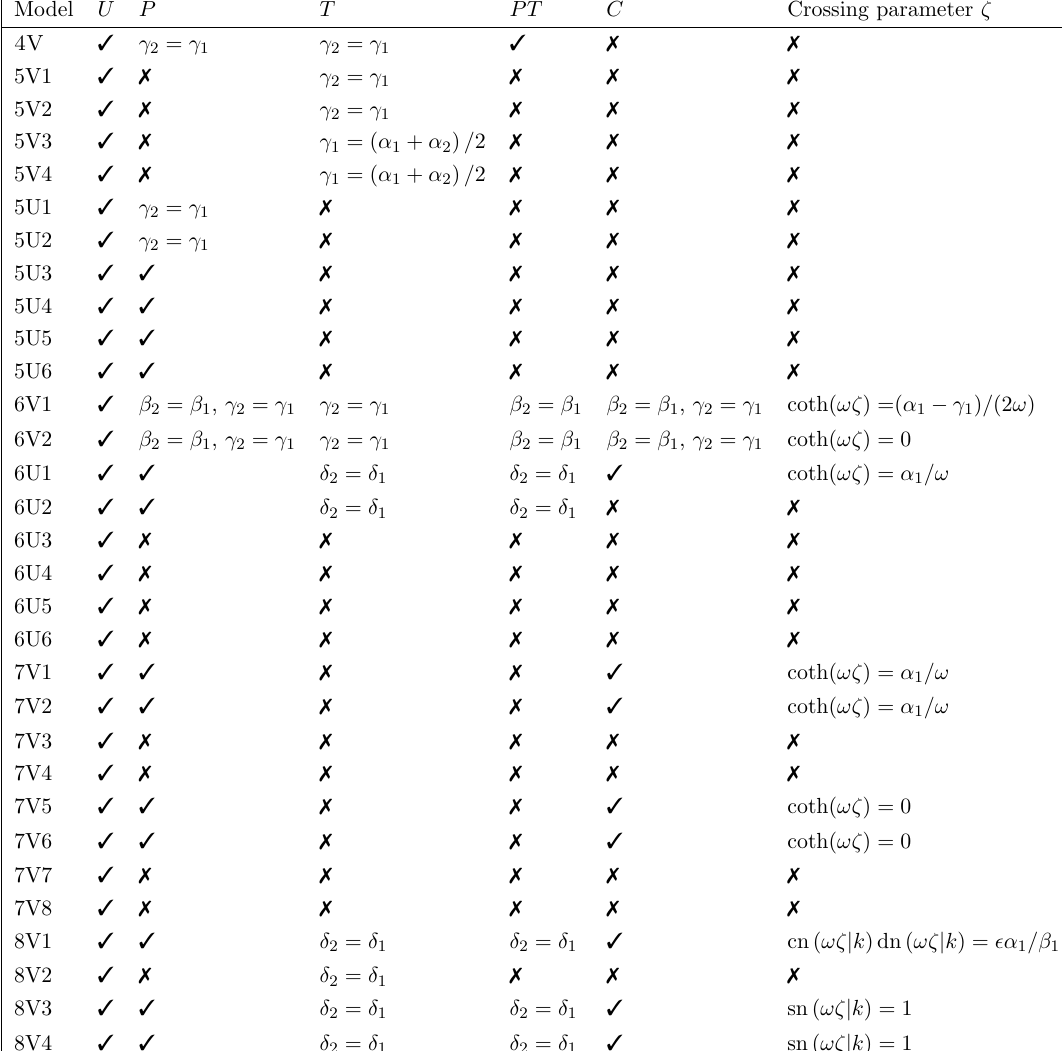
Table 2 . The unitarity ( U ), permutation ( P ), transposition ( T ), permutation-transposition ( PT ) and crossing ( C ) symmetries of the solutions, among with the relation de(cid:12)ning the crossing param- eter ( (cid:16) ), when available. The symbol 3 indicates that the solution has the corresponding symmetry without any constraint. If some conditions are necessary for the solution to have a given symmetry (in such a way that the shape of the R matrix remains the same), we write them down. Finally, the symbol 7 means that the solution cannot have the given symmetry at